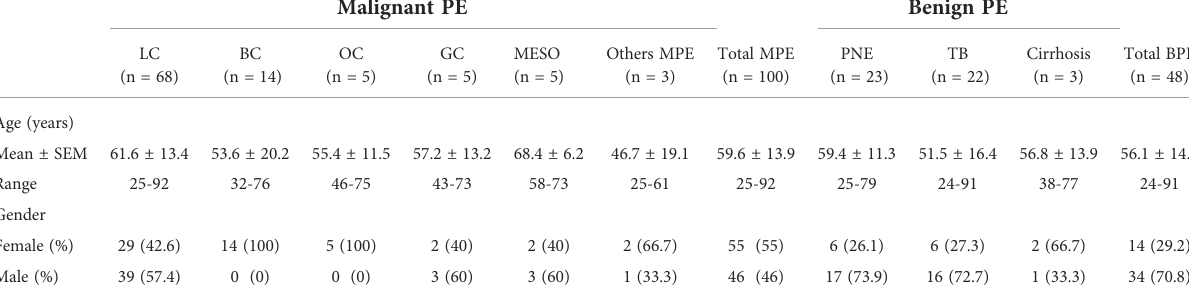
TABLE 1 Baseline characteristics of